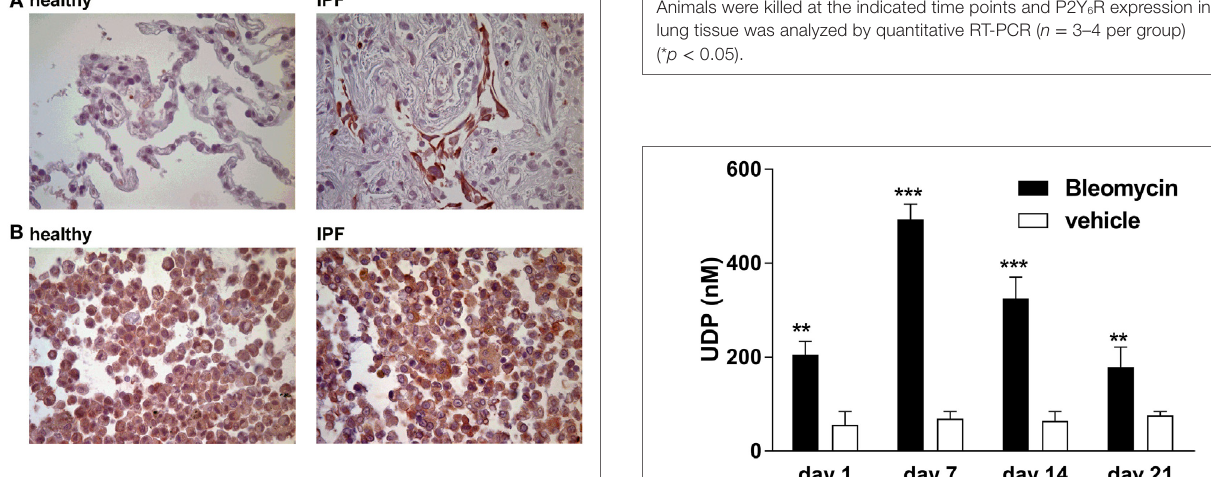
FigUre 1 | P2Y 6 R expression in idiopathic pulmonary fibrosis (IPF). (a) Immunohistochemical stainings for P2Y 6 R expression were performed with lung tissue derived from IPF patients ( n = 5) or controls (tumor-free margins from lung cancer resections; n = 5). (B) Bronchoalveolar lavage cells derived from IPF patients ( n = 5) and healthy volunteers ( n = 5) were stained for P2Y 6 R expression.